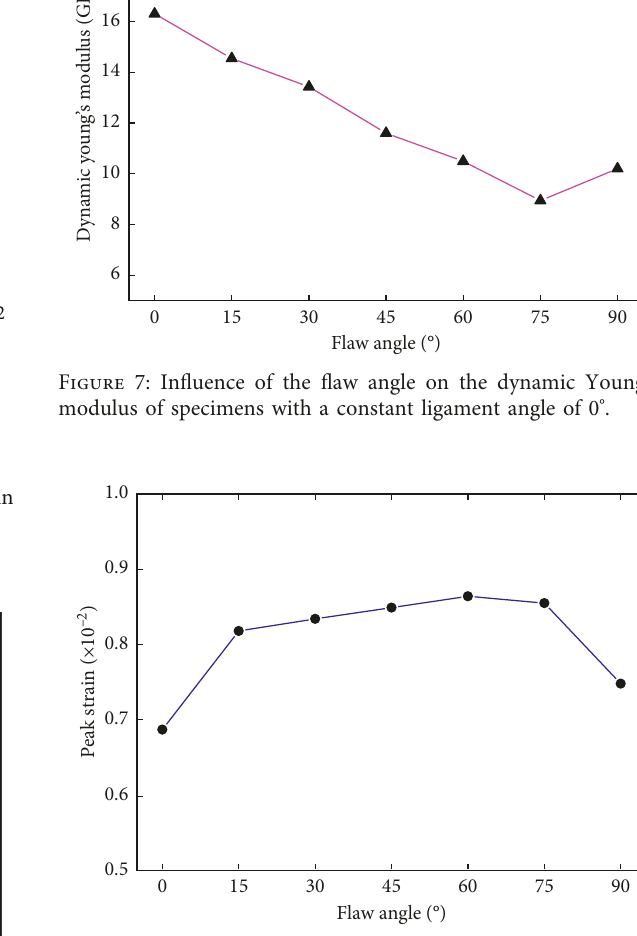
Figure 8: Influence of the flaw angle on peak strain of specimens with a constant ligament angle of 0 °